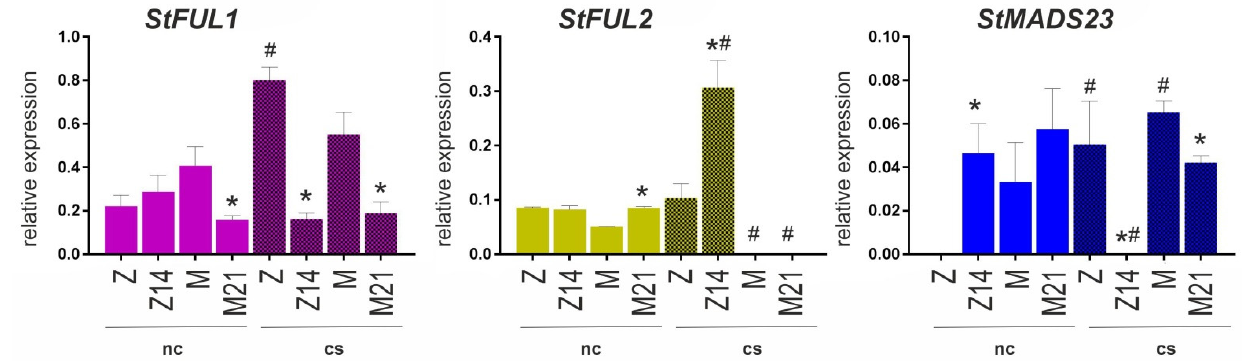
Figure 6. Expression of the StFUL1 , StFUL2 , and StMADS23 genes in the roots of potato cultivars Zhukovskii rannii (Z) and Mishka (M) and their transgenic lines Z14 and M21 in normal growth conditions (+21 ◦ C; nc) and in response to cold stress (+4 ◦ C for 3 days; cs). The data were normalized to ELF1 and SEC3A mRNA levels and presented as the mean ± SD ( n = 3); * p < 0.01 transgenic vs. wild-type plants; # p < 0.01 cold stress vs. normal conditions.